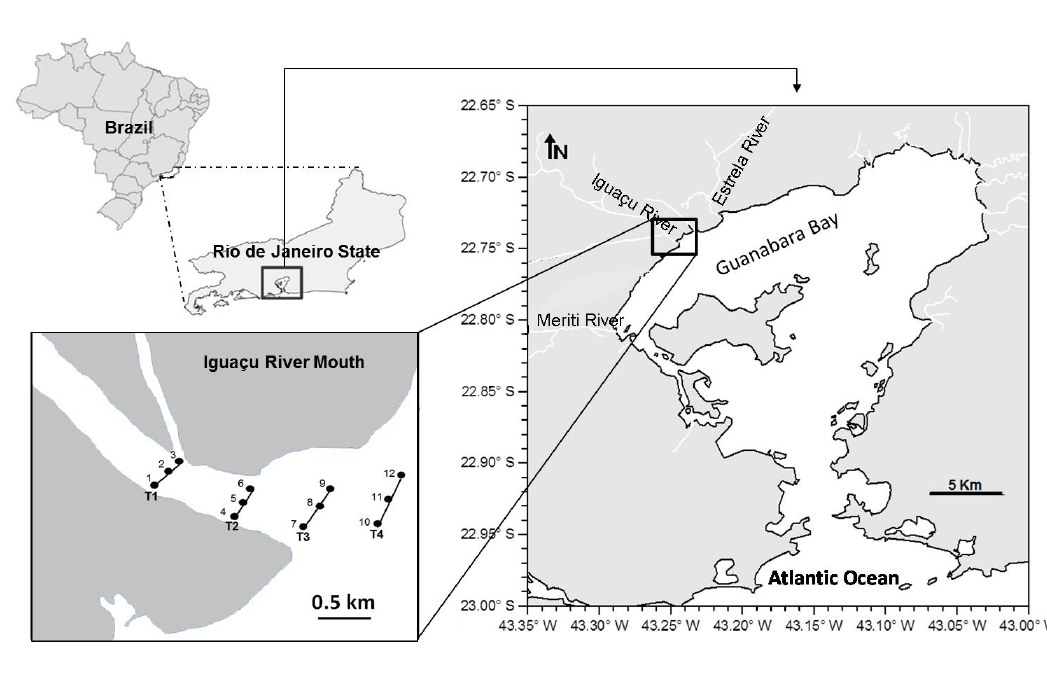
Figure 1. Transects at the mouth of Iguaçu River, northwestern sector of Guanabara bay-Rio de Janeiro, Brazil. T1: transect 1; T2: transect 2; T3: transect 3; T4: transect